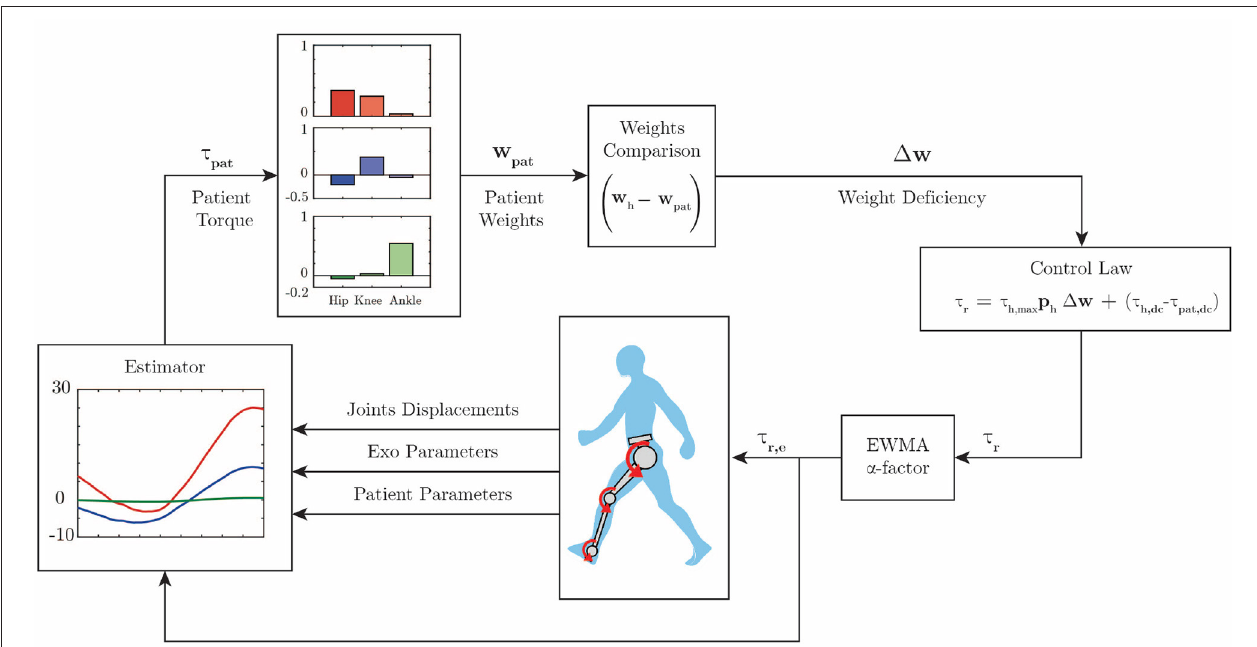
FIGURE 3 | Control diagram. The patient hip (red), knee (blue), and ankle (green) torques are estimated. Further, the motor primitive weights are extracted according to Equation (4). These weights are compared with reference weights, and then Equation (6) computes the assistive robot torque. The robot will exert an exponentially weighted moving average of the computed torque during the next swing